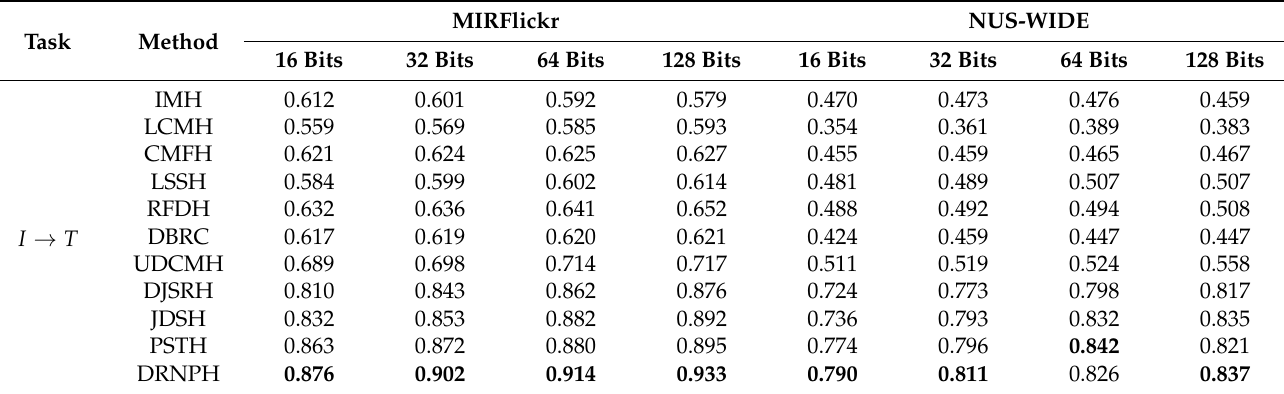
Table 2. The mAP@50 of image retrieving text.